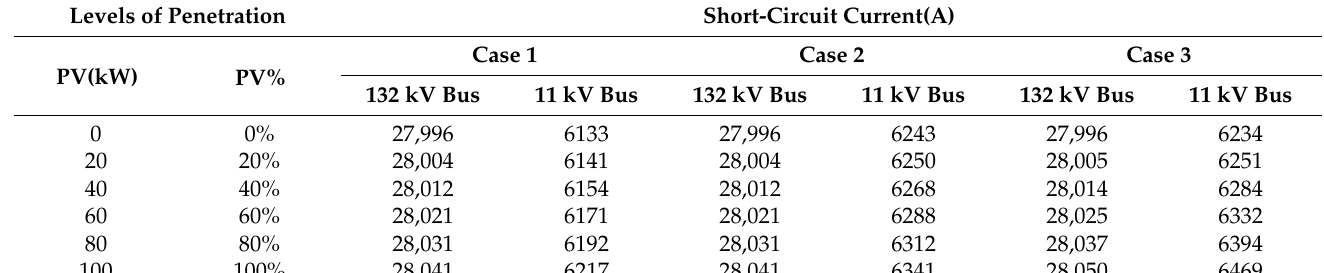
Table 4. A comparison of short-circuit currents during a period of peak load.